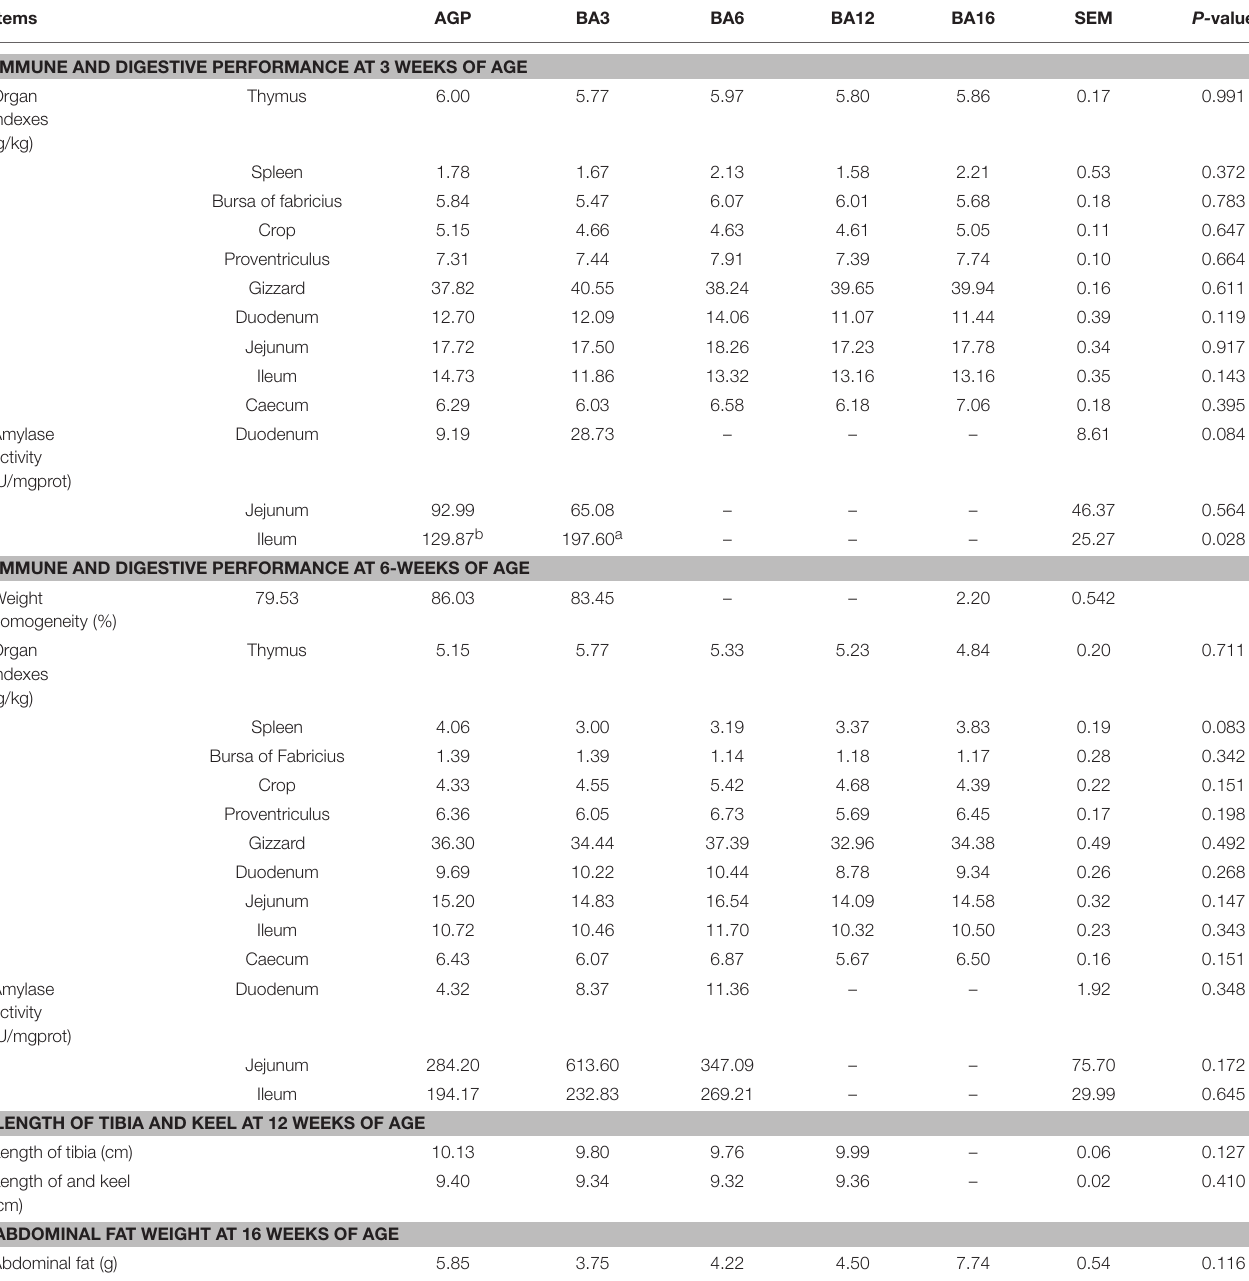
TABLE 4 | Immune and digestive performance in 0 ∼ 6-week-old pullets and skeleton growth and abdominal fat deposition in 7 ∼ 16-week-old pullets.